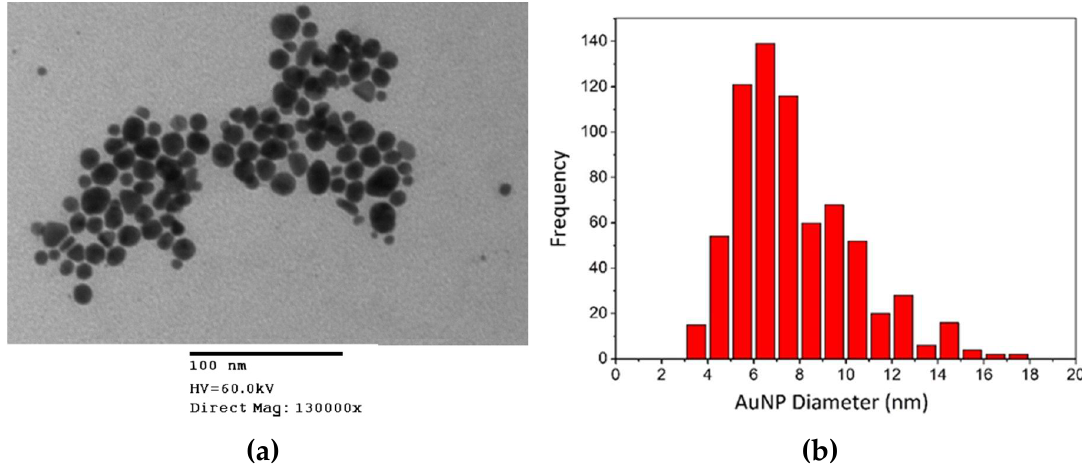
Figure 5. ( a ) TEM image of EGCG-AuNPs. The dark areas represent the AuNP cores where electron attenuation is high. ( b ) A histogram of Au core diameters of EGCG-AuNPs.